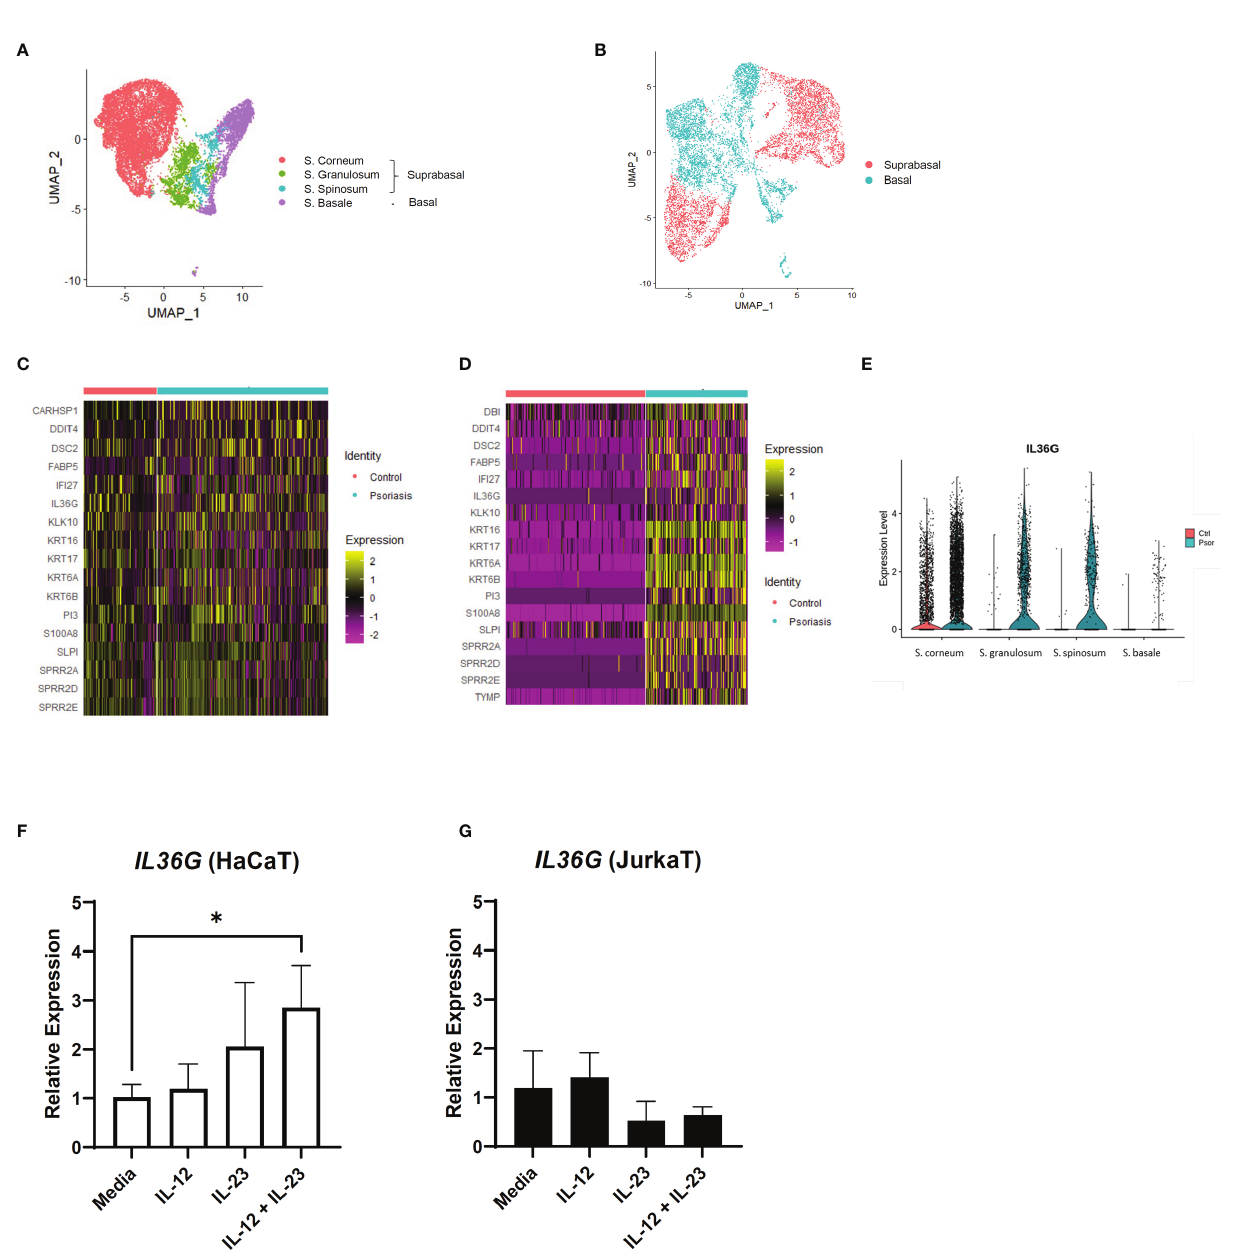
FIGURE 3 | IL36G and IL-23 expression in the keratinocytes of psoriasis patients and healthy controls. (A) Uniform Manifold Approximation and Projection (UMAP) of the keratinocyte cluster in GSE151177. (B) UMAP of the GSE162183 keratinocyte cluster based on KRT expression. (C, D) Differentially expressed genes between the healthy and psoriatic suprabasal epidermis in the keratinocyte clusters of GSE151177 (C) and GSE162183 (D) . Features omitted in the heatmap are due to the lack of data in the scale data slot of the studied datasets. (E) Violin plot of the IL36G expression in the different epidermal layers (GSE151177). (F, G) Relative expression of IL36G in the HaCaT cells after stimulation by recombinant human IL-12 and/or IL-23. Data are expressed as means ± SD. Lines above bars indicate statistical comparisons with signi fi cant differences between categories (* P <